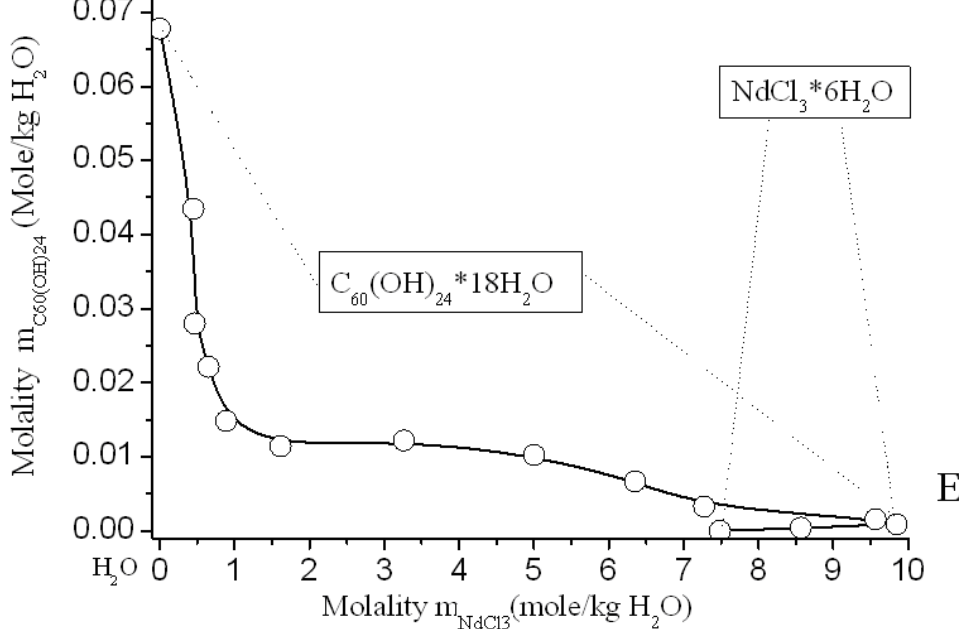
Figure 8. Solubility diagram in ternary system C 60 (OH) 24 —NdCl 3 —H 2 O at 25 °C.